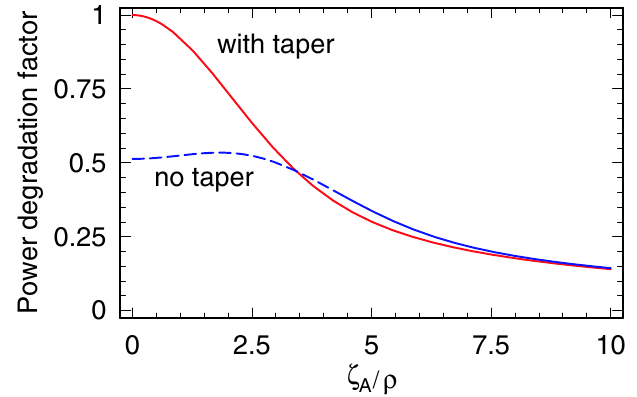
FIG. 15. (Color) Power degradation factor averaged over the core part of the bunch (with about 30 (cid:16) m in length) versus the =(cid:5) at the LCLS satu- sinusoidal wake oscillation amplitude (cid:18) A ration ( z (cid:1) 90 m ) for a prescribed tapered undulator (red solid curve) and without any taper (blue dashed curve) (from Ref.